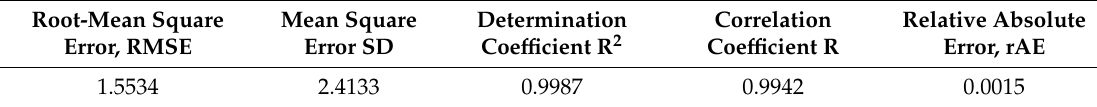
Table 3. Parameters values used to estimate the model